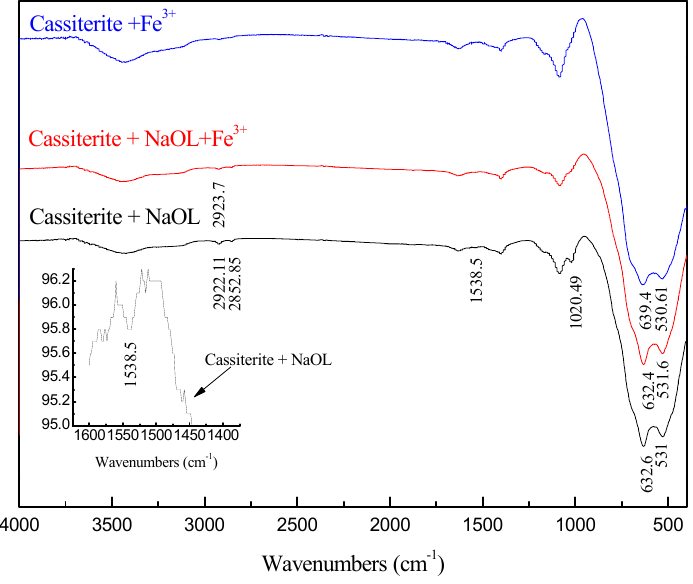
Figure 18. FTIR spectra of cassiterite with NaOL and/or Fe 3+ at pH 8 (NaOL: 4 × 10 − 4 mol/L; Fe 3+ : 8 × 10 − 5 mol/L).